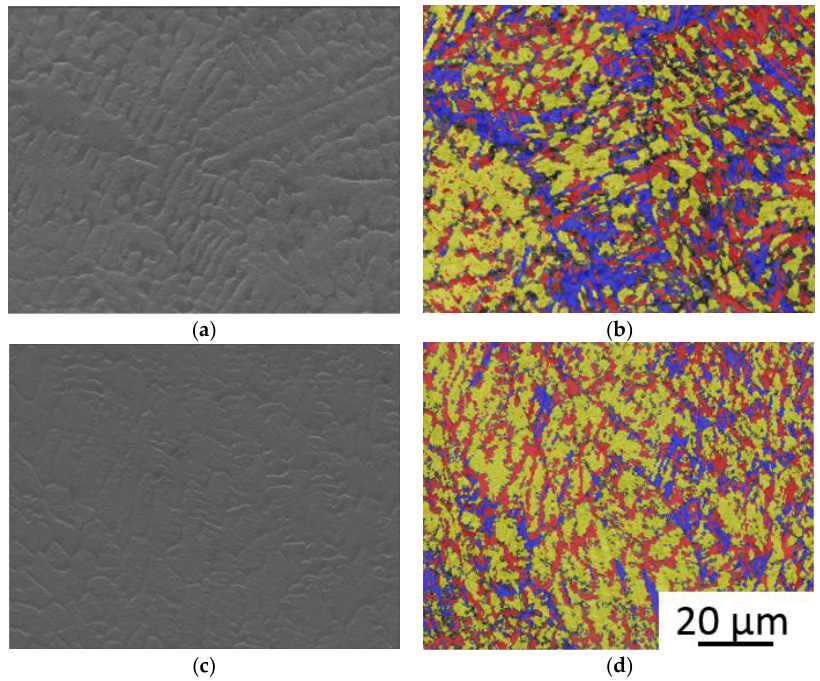
Figure 7. The EBSD analyses (with same magnification for all figures) of weld metals welded with